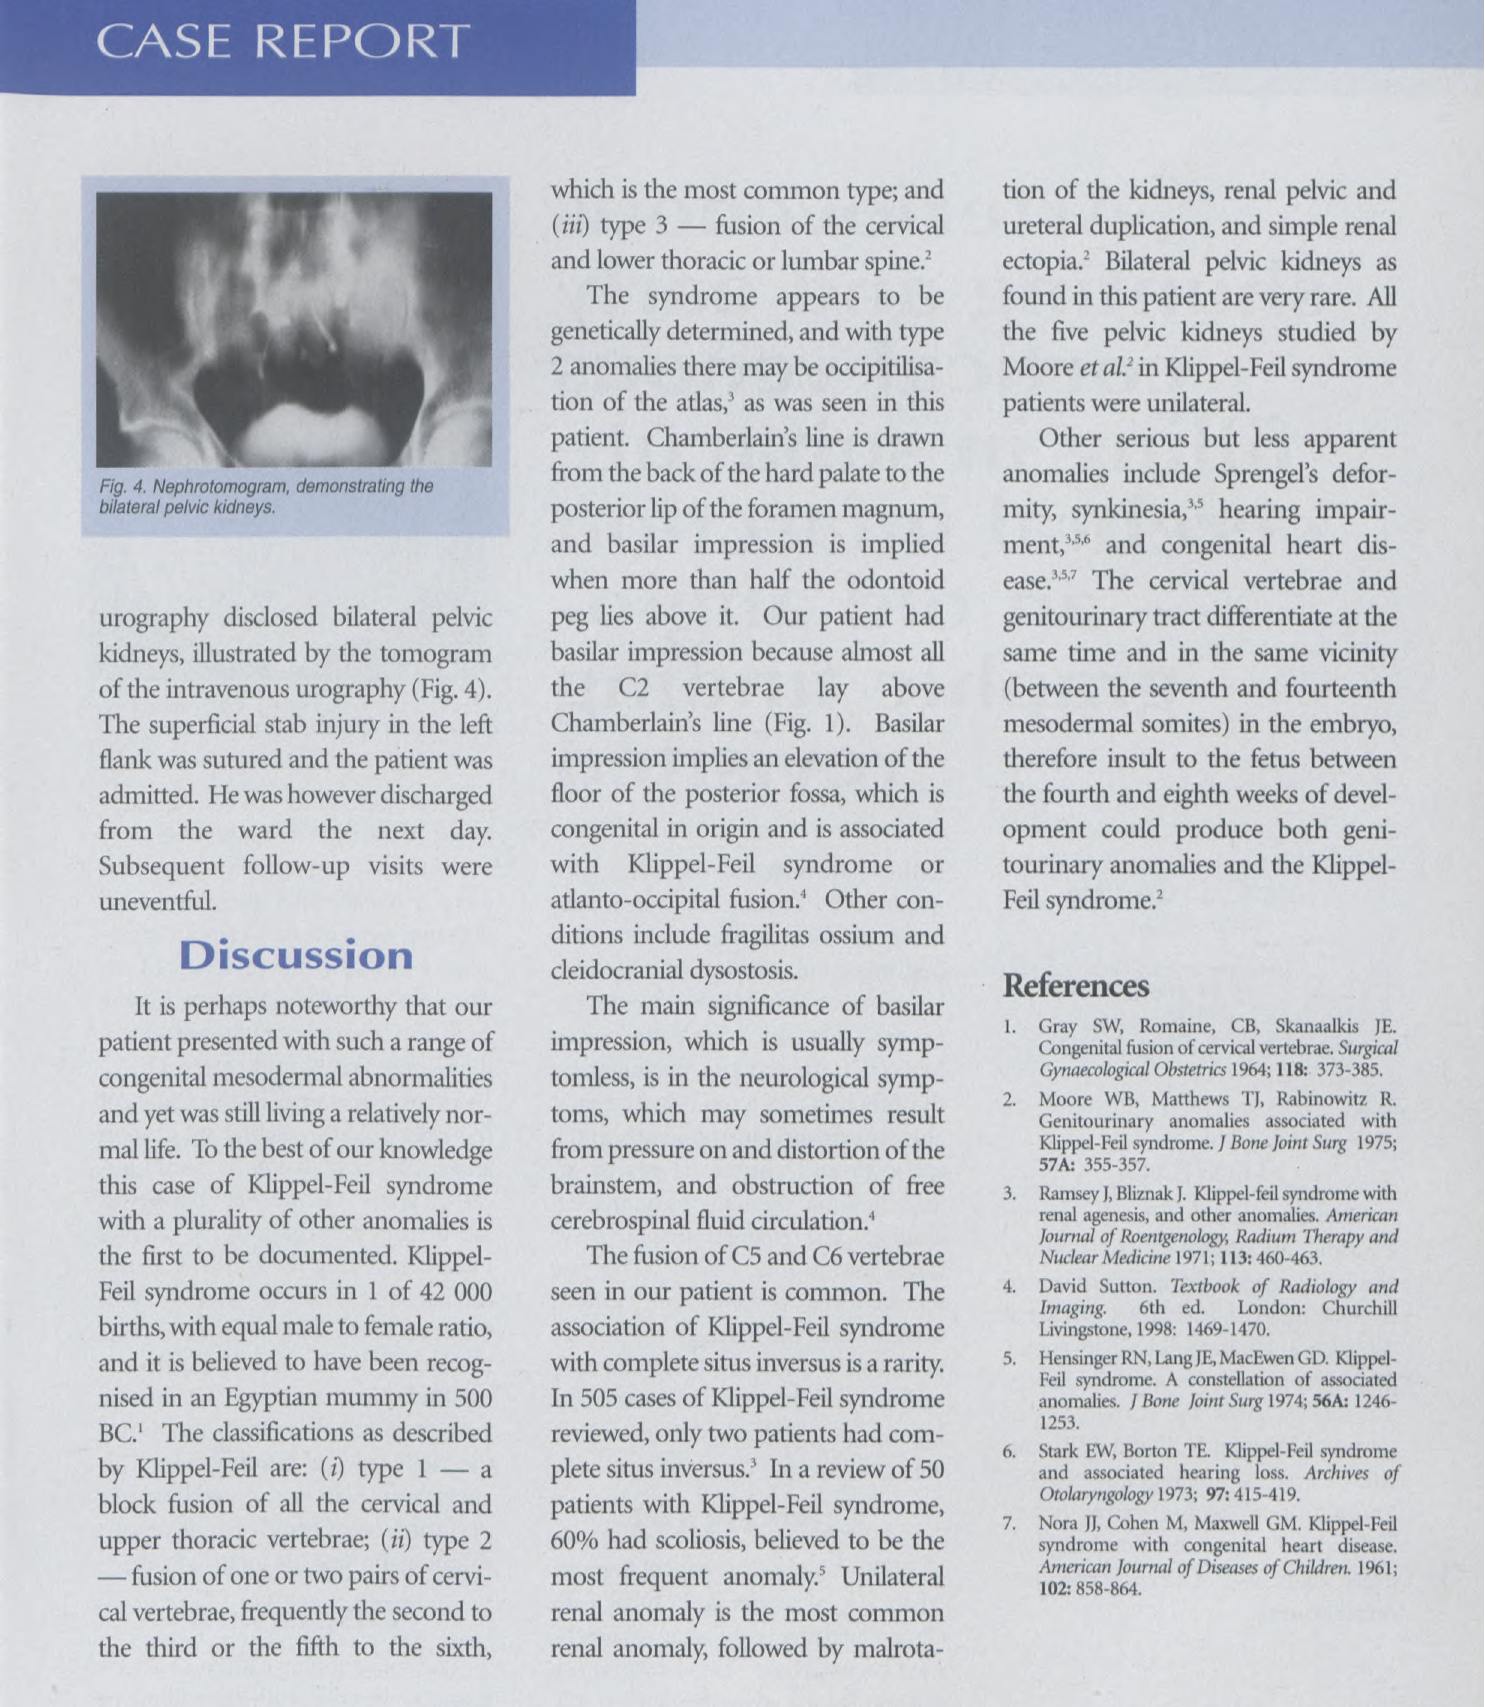
urography disclosed bilateral pelvic kidneys, illustrated by the tomogram of the intravenous urography (Fig.